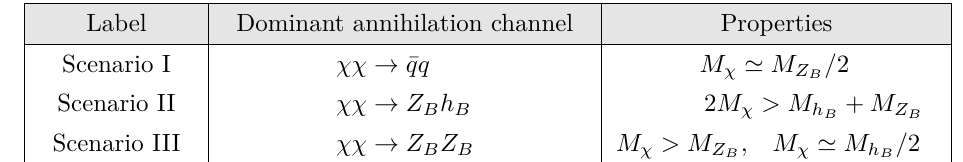
Table 1 . Classification of the three different scenarios for which the relic density bound Ω χ h 2 = 0 . 1200 ± 0 . 0012 [19] is satisfied in the minimal theory for local baryon